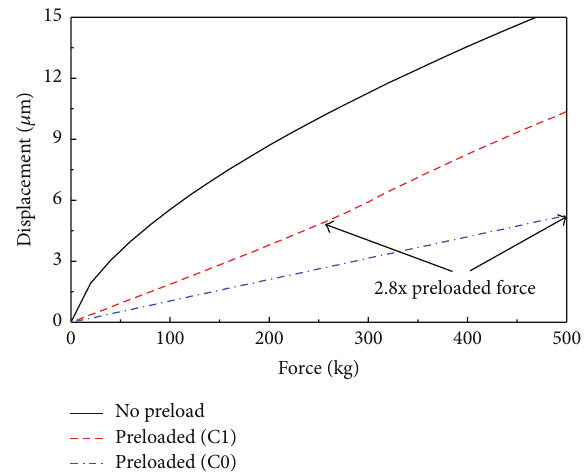
Figure 1: The displacement of a linear motion bearing as a function of the applied force.